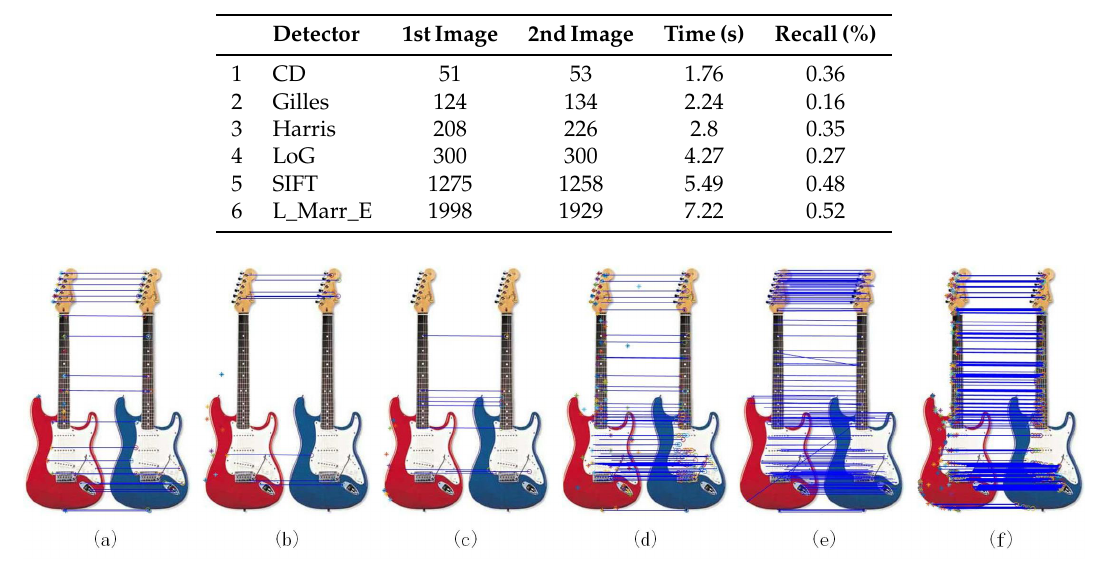
Figure 11. Feature points matching under different algorithms: ( a ) CD ( b ) Gilles ( c ) Harris ( d ) LoG ( e ) SIFT and ( f )